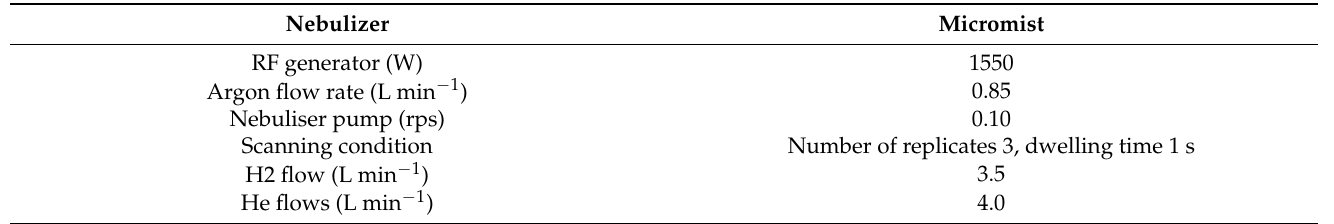
Table 1. The ICP-OES operating